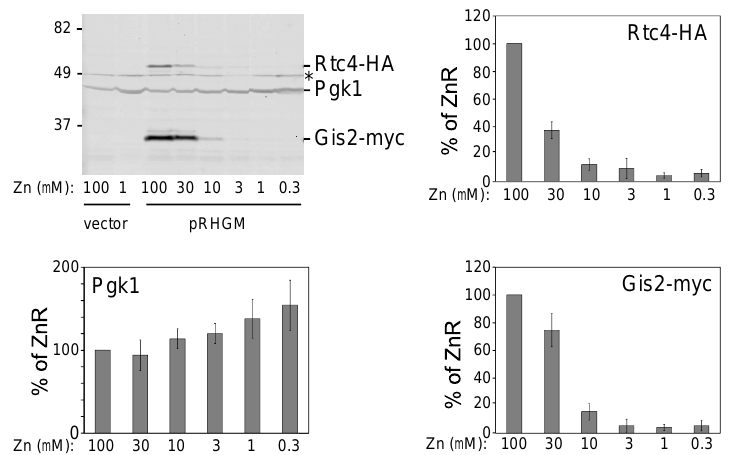
Figure 3. Correlation Rtc4 and Gis2 protein expression in response to zinc status. Wild-type (BY4741) cells transformed with plasmid pRHGM were grown in LZM with the indicated zinc level for 16 h prior to immunoblot analysis. pRHGM expresses HA-tagged Rtc4 and myc-tagged Gis2. Pgk1 was used as a loading control and the asterisk marks a non-specific band. The location of size markers is indicated on the left side of the panel in kDa. The histograms show quantified results from three replicates compared to 100 µM zinc cultures as the replete (ZnR) condition. Error bars are ± 1 SD.